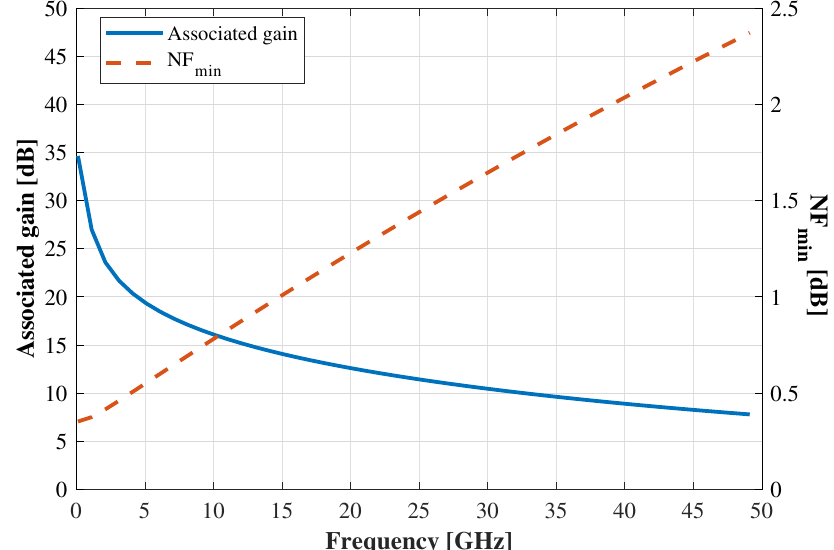
Figure 5. Simulated associated gain and minimum noise figure (NFmin) of a 4 × 35 µ m device predicted by the small signal extracted model at V DS = 5 V, V GS = − 1.5 V. At 35 GHz, values are 9 dB and 1.85 dB, respectively.